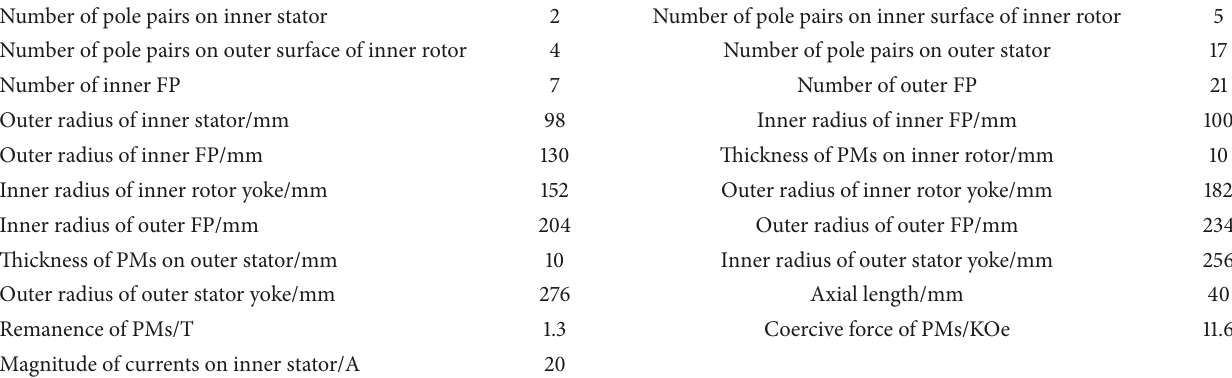
Table 1: Parameters of example EIMG